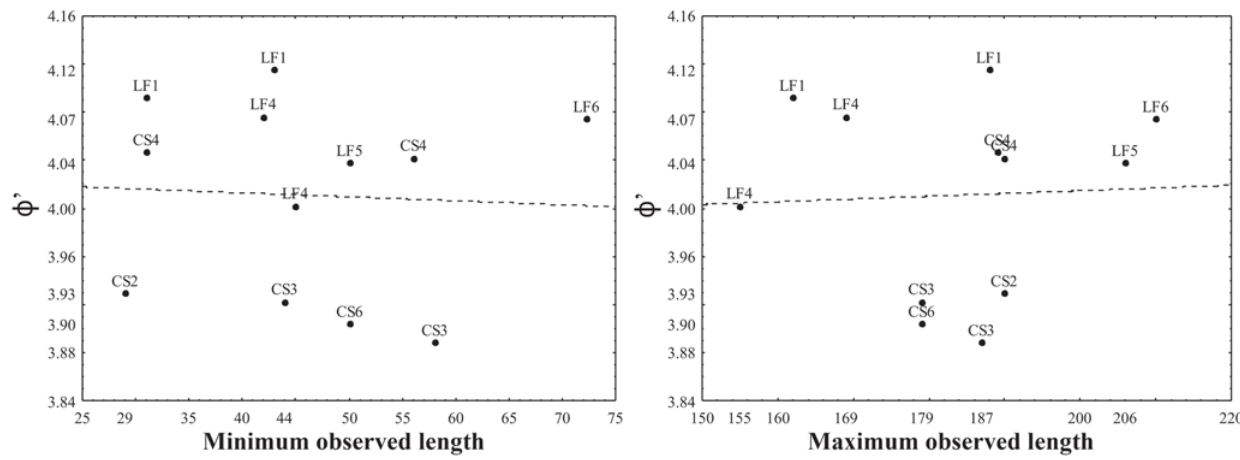
Fig. 6. Dispersion plot of growth performance index ( (cid:5) ’) against minimum and maximum observed lengths derived from different age and growth studies for the Atlantic bigeye tuna, T. obesus . Letters in labels represent the ageing technique: CS - calcified structure, LF - Length frequency; and numbers represent the sampling area: 1 - entire ocean, 2 - Eastern, 3 - Eastern Temperate, 4 - Eastern, 5 - Central, and 6 -